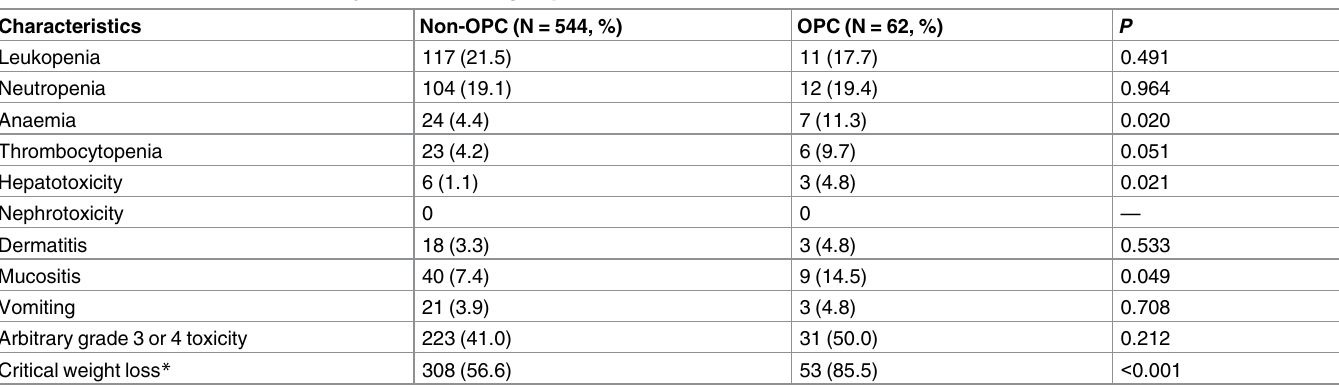
Table 2. Grade 3 or 4 acute toxicities by non-OPC/OPC group.